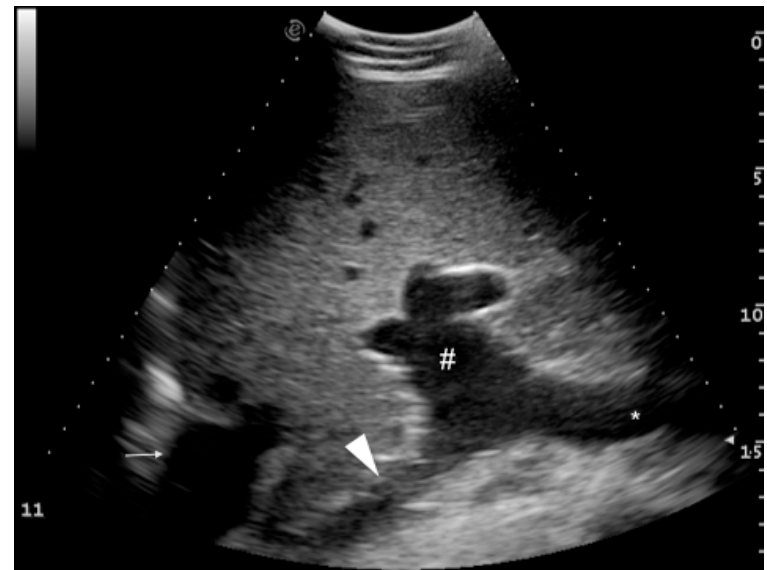
Figure 2. Ultrasound image showing the typical inverted “T” shape of the image due to the confluence of the splenic (arrowhead) and cranial mesenteric veins (*), conforming the main portal vein (#) at the porta hepatis . Image obtained in a slightly craniocaudal orientation in the 11 th intercostal space (depth is shown on the right of the image). Dorsal location is on the left of the image. Caudal vena cava is located to the left of the image (small arrow).